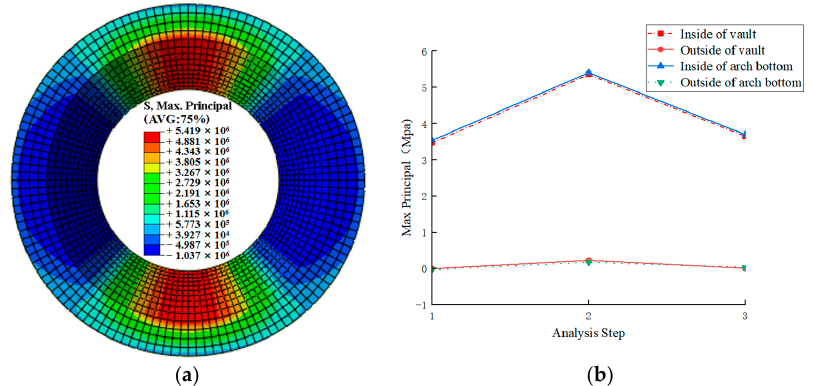
Figure 12. Stress characteristics of the lining. ( a ) Maximum principal stress of the lining. ( b ) Value of tensile part of the lining.